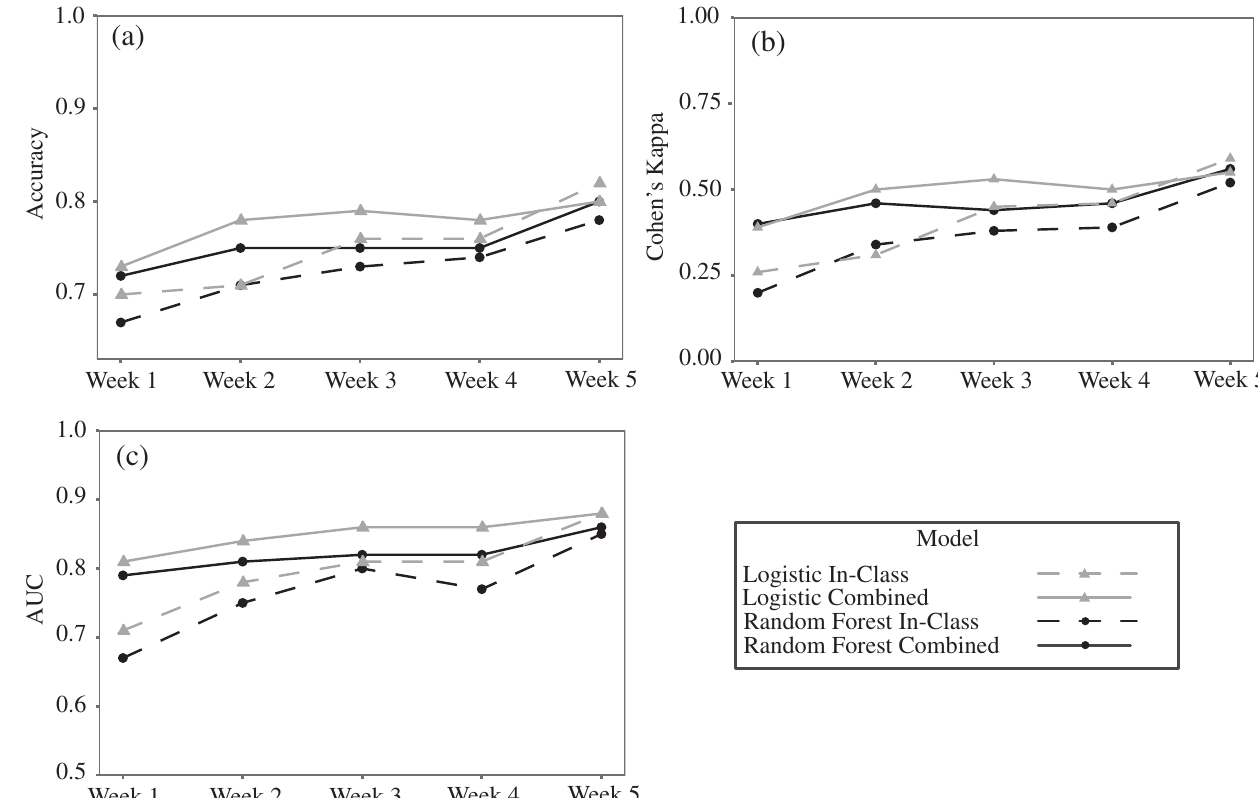
FIG. 1. Physics 1: Model accuracy (a), Cohen ’ s κ (b), AUC (c). The horizontal axis represents the performance of the baseline model in each plot.